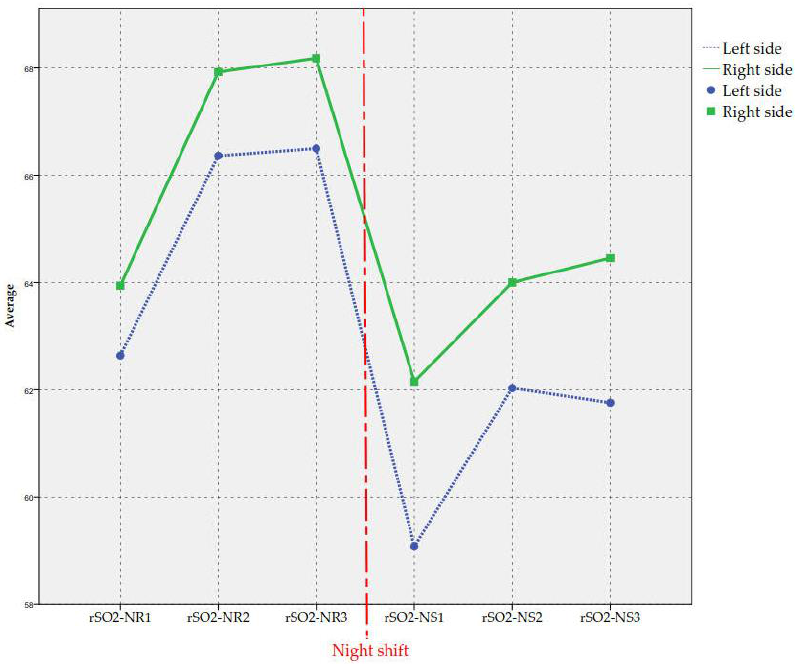
Figure 1. Evolution of average rSO 2 scores.